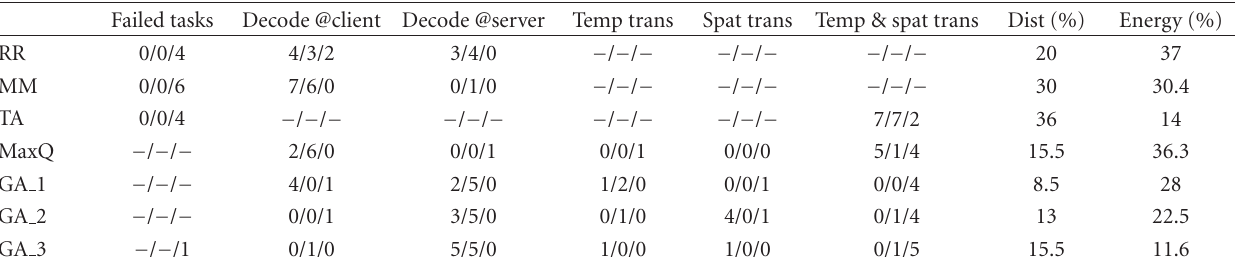
Table 6: Assignment strategies for HD/SD/CIF